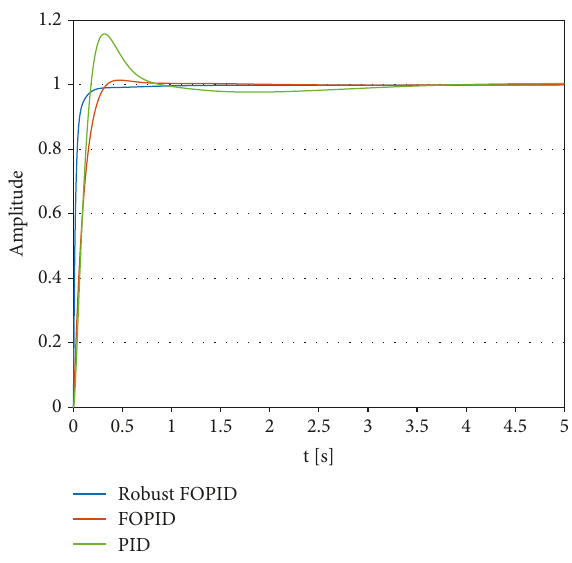
Figure 8: Step response comparison of G